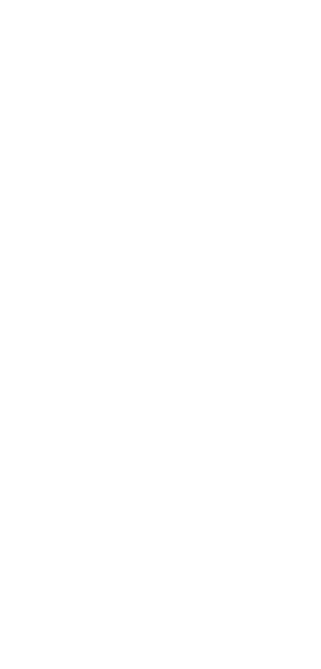
Figure 4. Filled funnel plot for the relation between household solid fuel use and birth weight (A), low birth weight (B) and stillbirth (C).